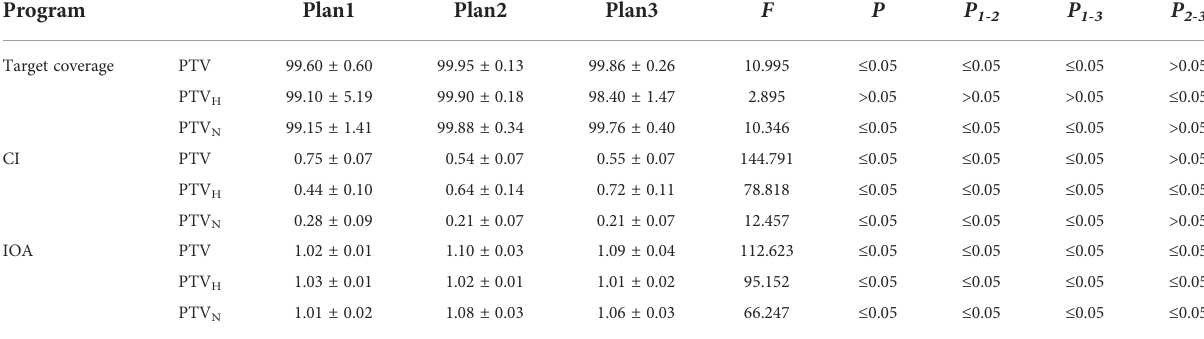
TABLE 2 Comparison of target coverage, CI and IOA among three plans. Program